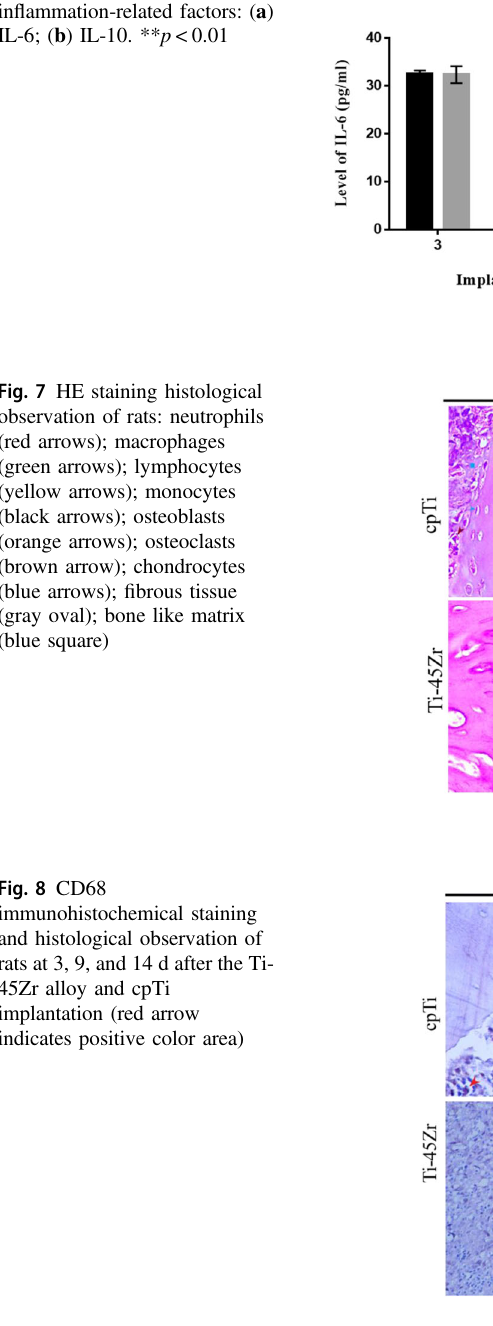
Fig. 6 Serum concentrations of in fl ammation-related factors: ( a ) IL-6; ( b ) IL-10. ** p <